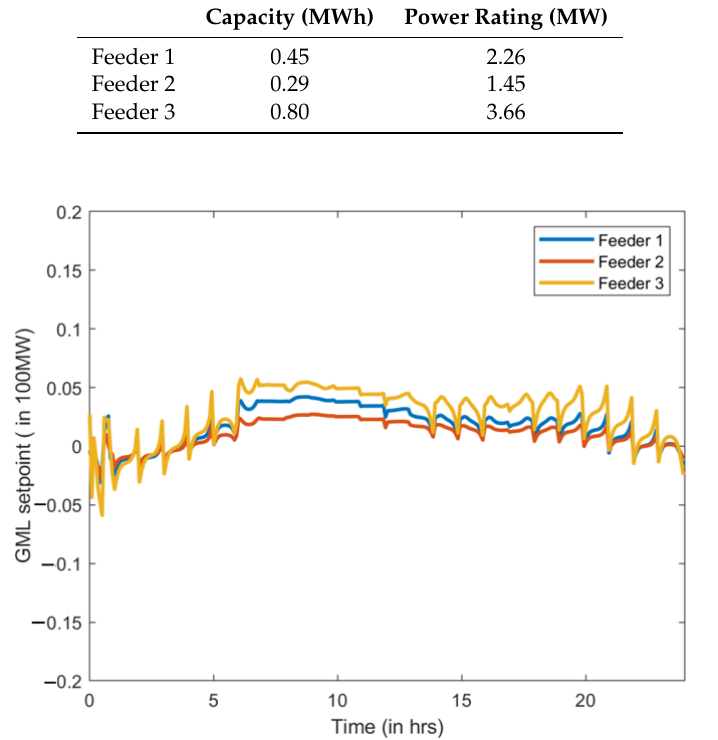
Table 3. Aggregate virtual battery parameters for each feeder.